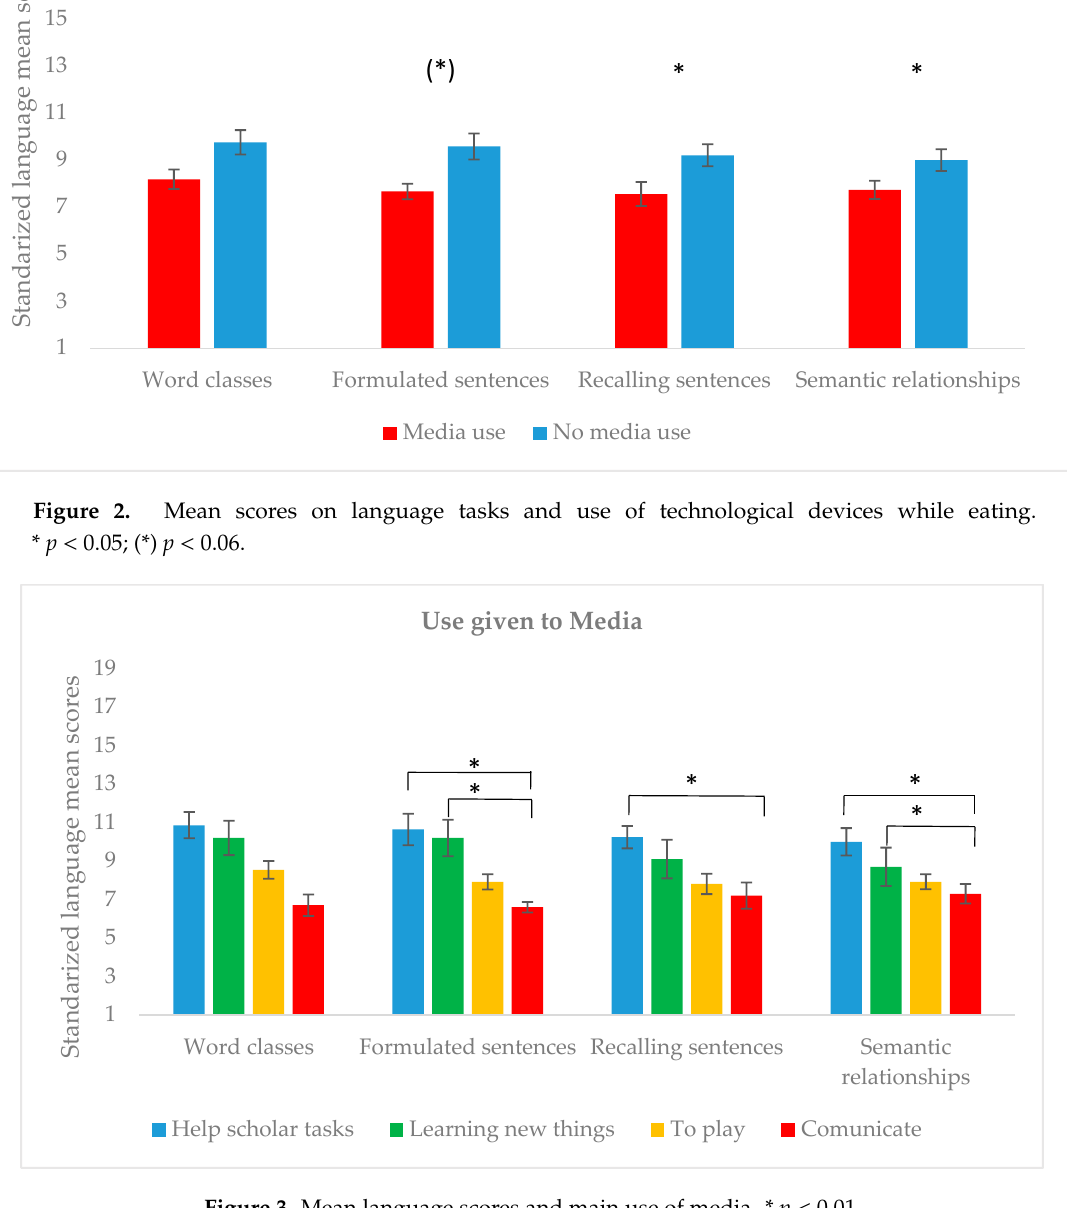
Figure 4. Mean language score and amount of verbal interaction with parents. * p < 0.001. Finally, the frequency distribution analysis between the use of media in minutes and the tendency to talk with the parents (see Figure 5) showed that participants who considered that they did not talk much with their parents used technological devices in higher rates of time ( χ ² (2,60) = 19.495, p < 0.0001). Post-hoc tests using standardized residuals revealed that among preteens with the lowest amount of daily use of media, there were significantly more participants who talk frequently with their parents (Z adj = 3.96, p < 0.001). In addition, participants who spent the highest rates of time with media every day report talking with their parents less frequently (Z adj = 3.87, p < 0.001). There were no differences in terms of the frequency of self-reported interaction with their parents among preteens who spend intermediate time levels with media per day (one hour per day) (Z adj = 0.6, p = 0.835).